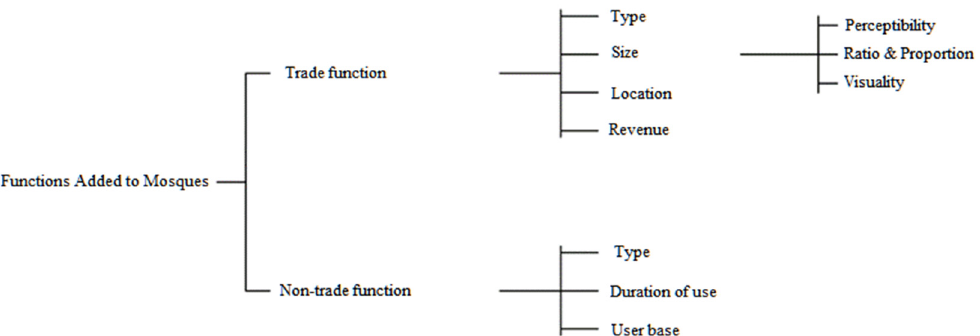
Figure 19. Variables for functions added to the mosques.